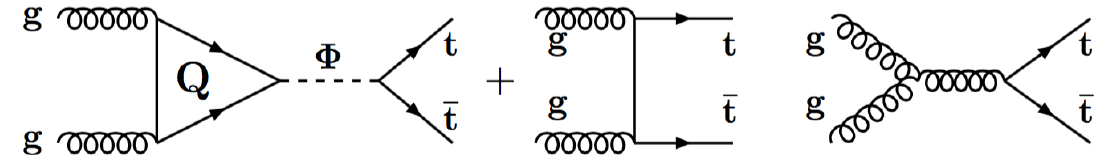
Figure 1 . Feynman diagrams for the signal process gg ! (cid:8) ! t (cid:22) t and the QCD process gg ! t (cid:22) t that is the dominant background at the LHC. The state (cid:8) may represent either a CP-even state H or a CP-odd A